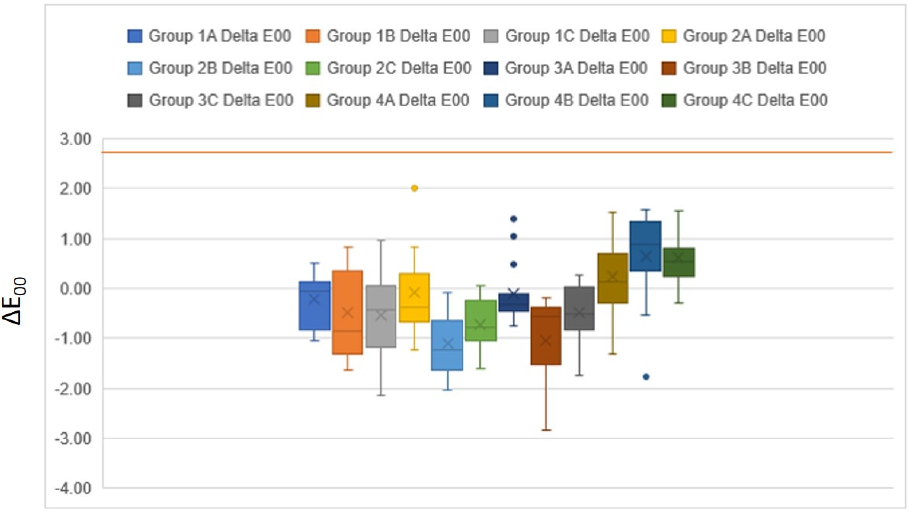
Figure 5. Effect of denture cleansers on the color of different resin groups. The brown line represents the clinically acceptable threshold ( Δ E 00 = 2.8).